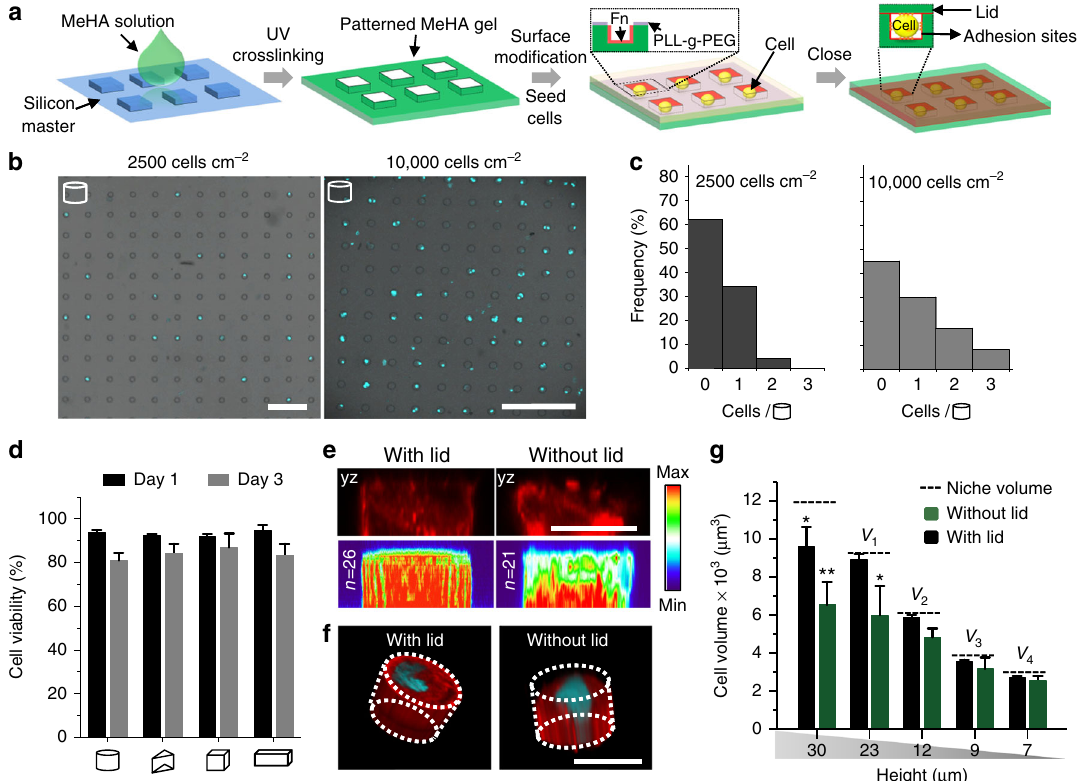
Fig. 1 3D microniche preparation and single hMSC encapsulation. a Schematic of the method to encapsulate single cells in a 3D microniche. b Fluorescence image shows nuclear staining of single cells encapsulated in a 3D microniche with cylindrical geometries at different cell densities (2500 and 10,000 cells cm − 2 ), scale bar: 100 µ m. c Cell encapsulation ef fi ciency at different cell densities in the 3D microenvironment with cylindrical geometry. d Quanti fi cation of cell viability (by live/dead staining) after 1 and 3 days of culture in a 3D microniche with different geometries; n ≥ 4 regions of interest (ROI) with a total of 80 – 100 cells analyzed. e Side view and fl uorescent heat maps of actin organization in a microenvironment with and without lid, red: F-actin, scale bar: 20 µ m. f 3D organization of actin cytoskeleton in a microenvironment with and without lid, red: F-actin, blue: nuclear, scale bar: 20 µ m. g Quanti fi cation of cell volume after 24-h culture in a microenvironment with and without lid; n = 50 – 60 cells analyzed for each data point. The microniche volume was controlled by changing the height (from 7 to 30 µ m), with a constant value for project area (400 µ m 2 ). Data are shown as mean ± s.d. for all panels, and * P < 0.05, ** P < 0.01 (ANOVA using a Tukey post-test), compared to theoretical niche volume. Microniches with heights 23, 12, 9, and 7 µ m are denoted as Stress fi bers and F-actin polymerization in a 3D microniche .